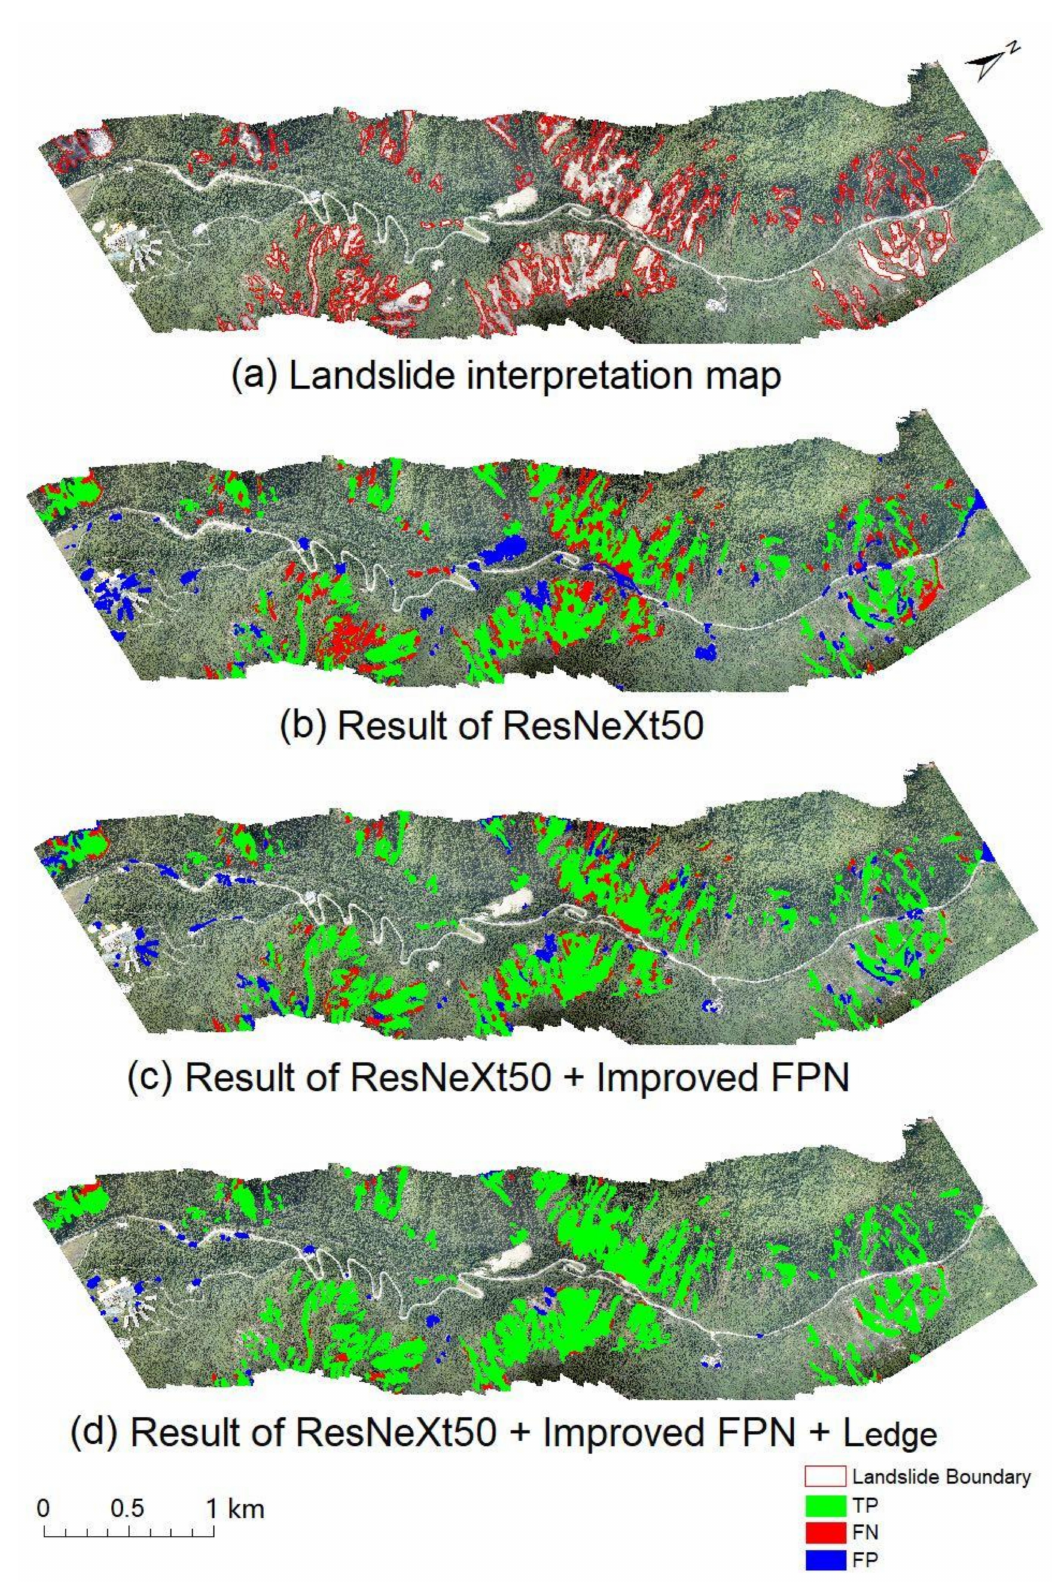
Figure 12. Extraction